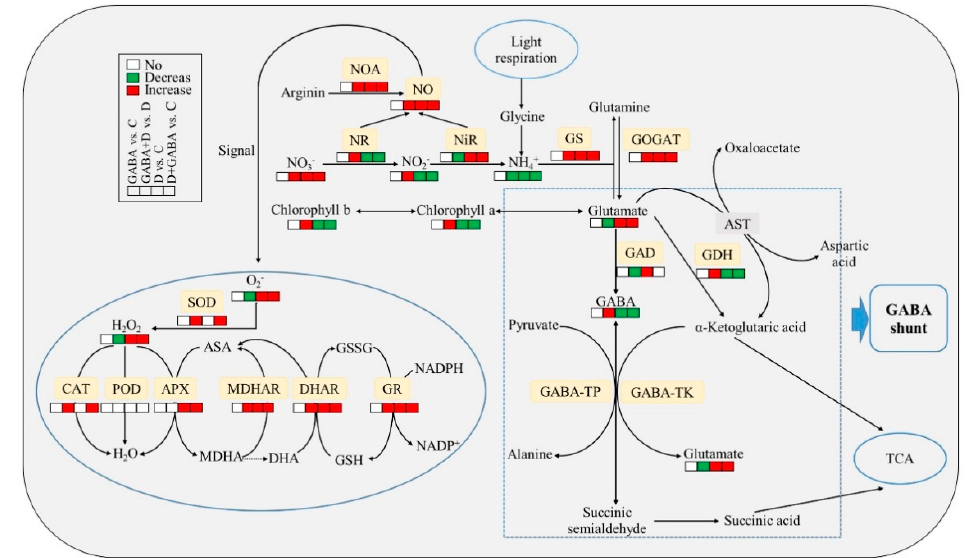
Figure 9. Integrative pathways induced by water stress and exogenous application of γ -aminobutyric acid (GABA) in leaves of creeping bentgrass under non-stress and water stress conditions. Red indicates a significant upregulation, green indicates a significant downregulation, and white indicates no significant change. C, well-watered control; GABA, well-watered control pretreated with GABA; PEG, PEG-induced water stress; GABA + PEG, water-stressed plants pretreated with GABA.